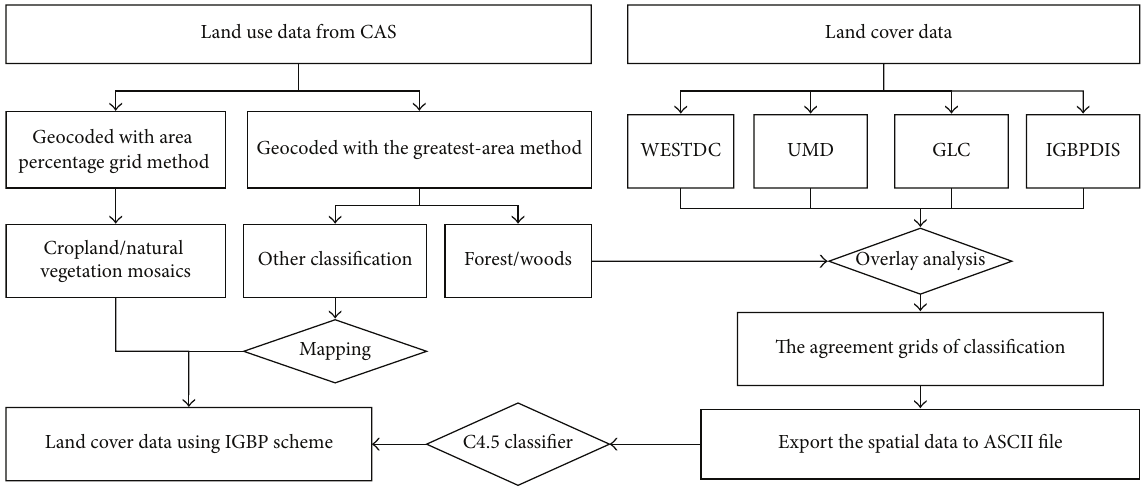
Figure 2: The work flow of mapping based on multisource spatial data mining approach.